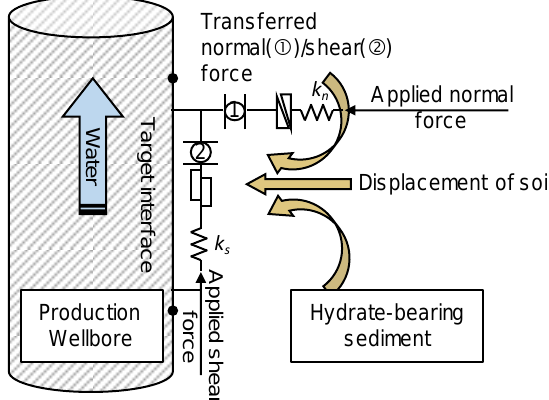
Figure 1. Concept of transferring the normal and shear stress at the interface under the depressurization method.